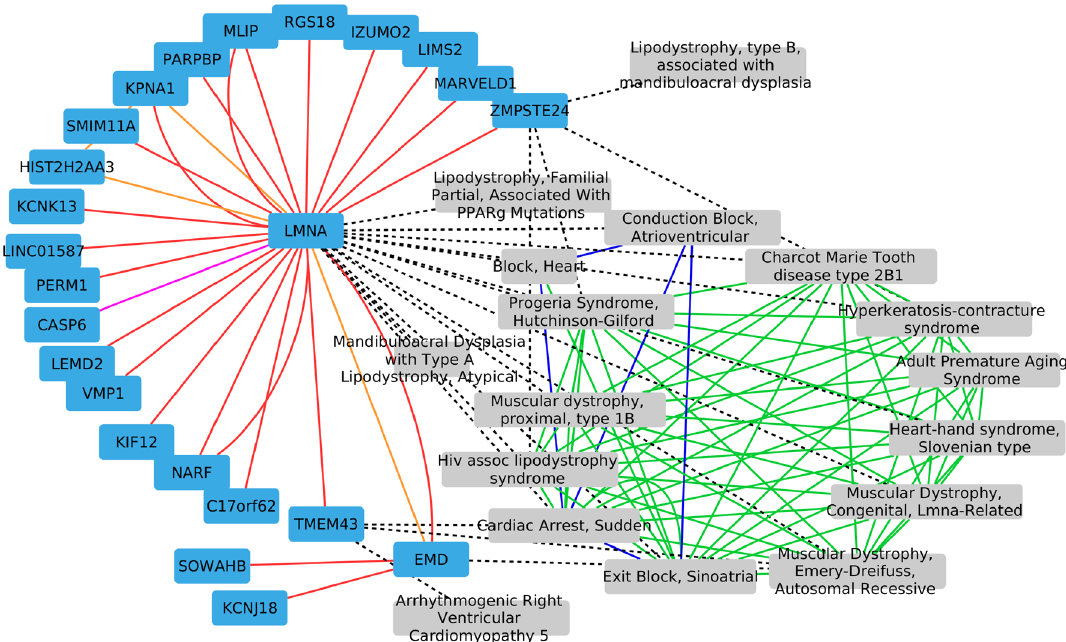
Figure 5. Cluster containing the HGPS disease node. Disease-Disease edges from the disease multiplex network are represented in green (shared symptoms) and blue (CTD projection). Gene-Gene edges from the molecular multiplex network are represented in pink (Reactome pathways), red (protein-protein interactions) and orange (molecular complexes). Gene-Disease bipartite interactions are represented with black dashed